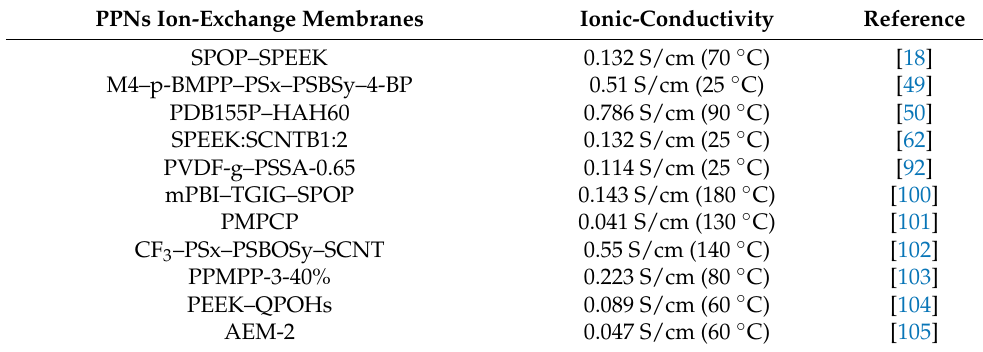
Table 1. The performance of polyphophazenes membranes for fuel